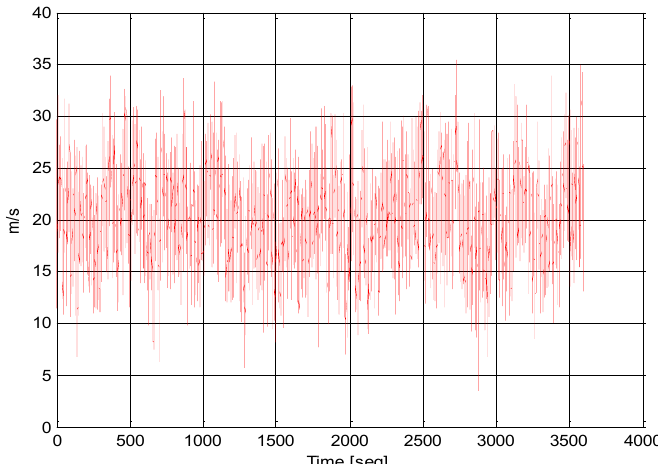
Figure 1. Wind speed realization calculated with TurbSim.